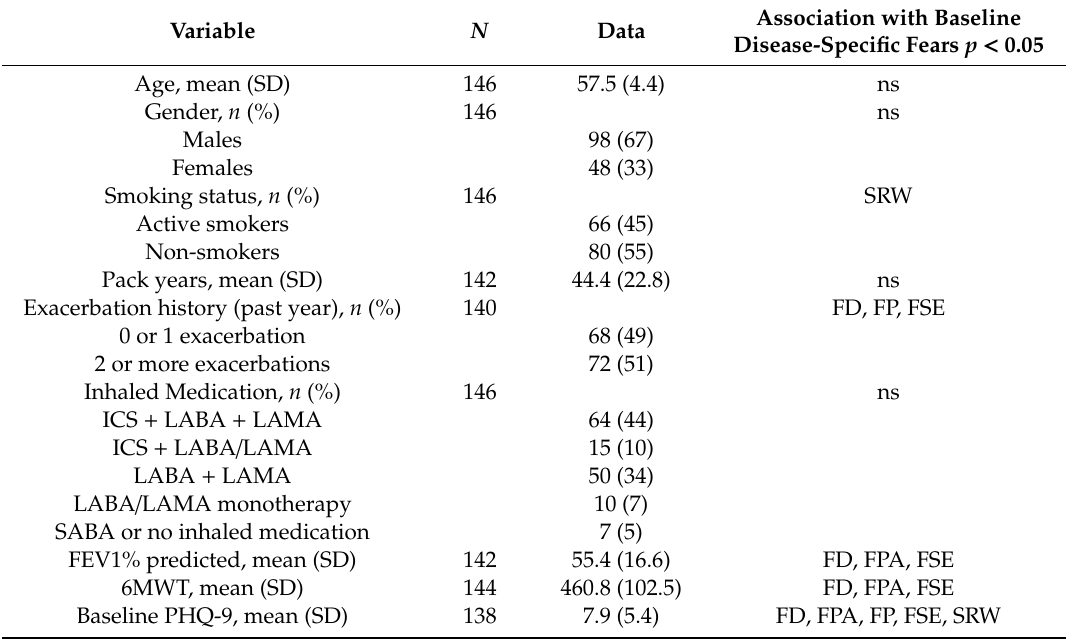
Table 1. Baseline characteristics of